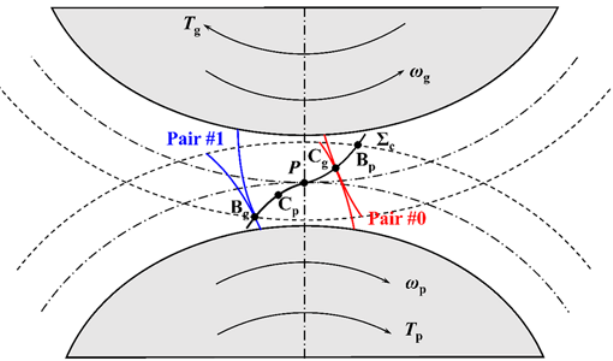
Fig. 1. Contact pattern in spur gear drive with curved path